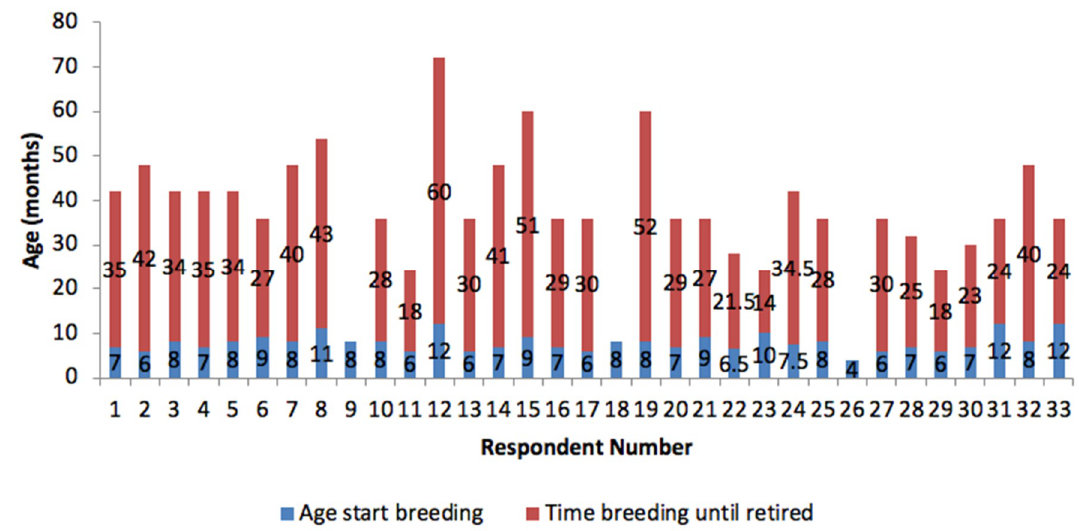
Figure 2. Breeding age and months until cessation of breeding for does shown per Figure 2 . Breeding age and months until cessation of breeding for does shown per breeder.